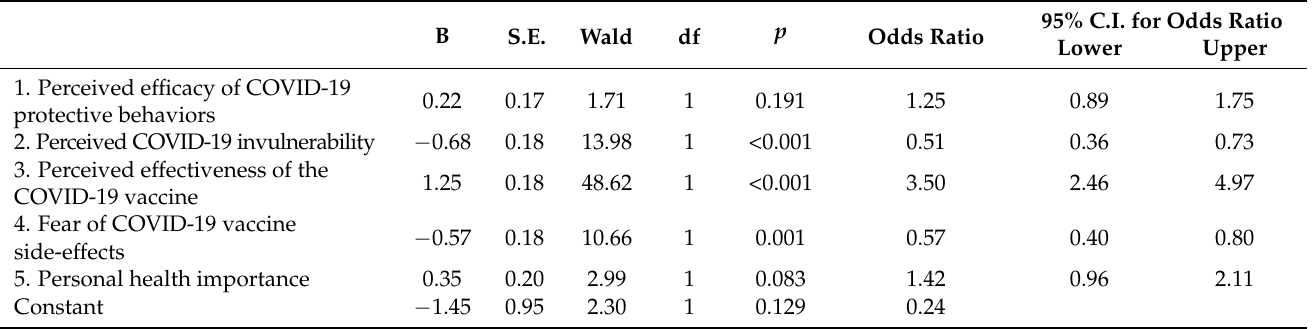
Table 4. Logistic regression predicting COVID-19 vaccine uptake from COVID-19 health